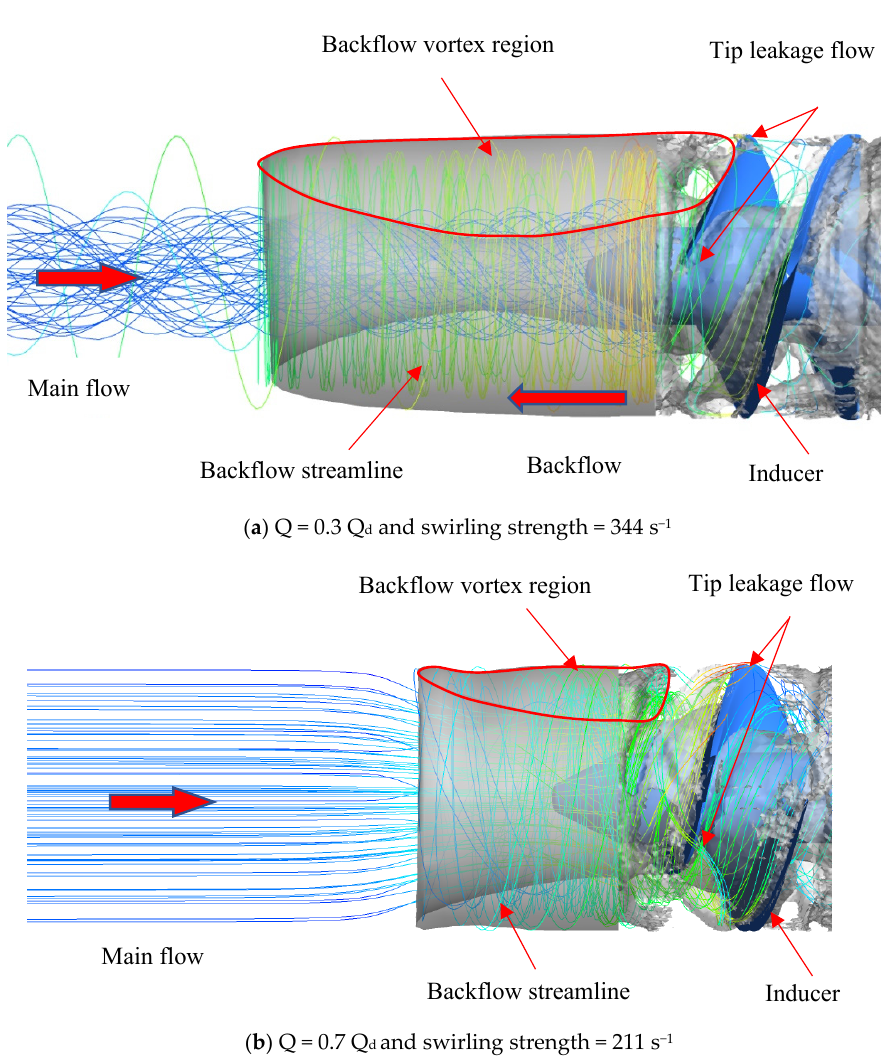
Figure 8. Schematic diagram of the internal flow of the inducer.